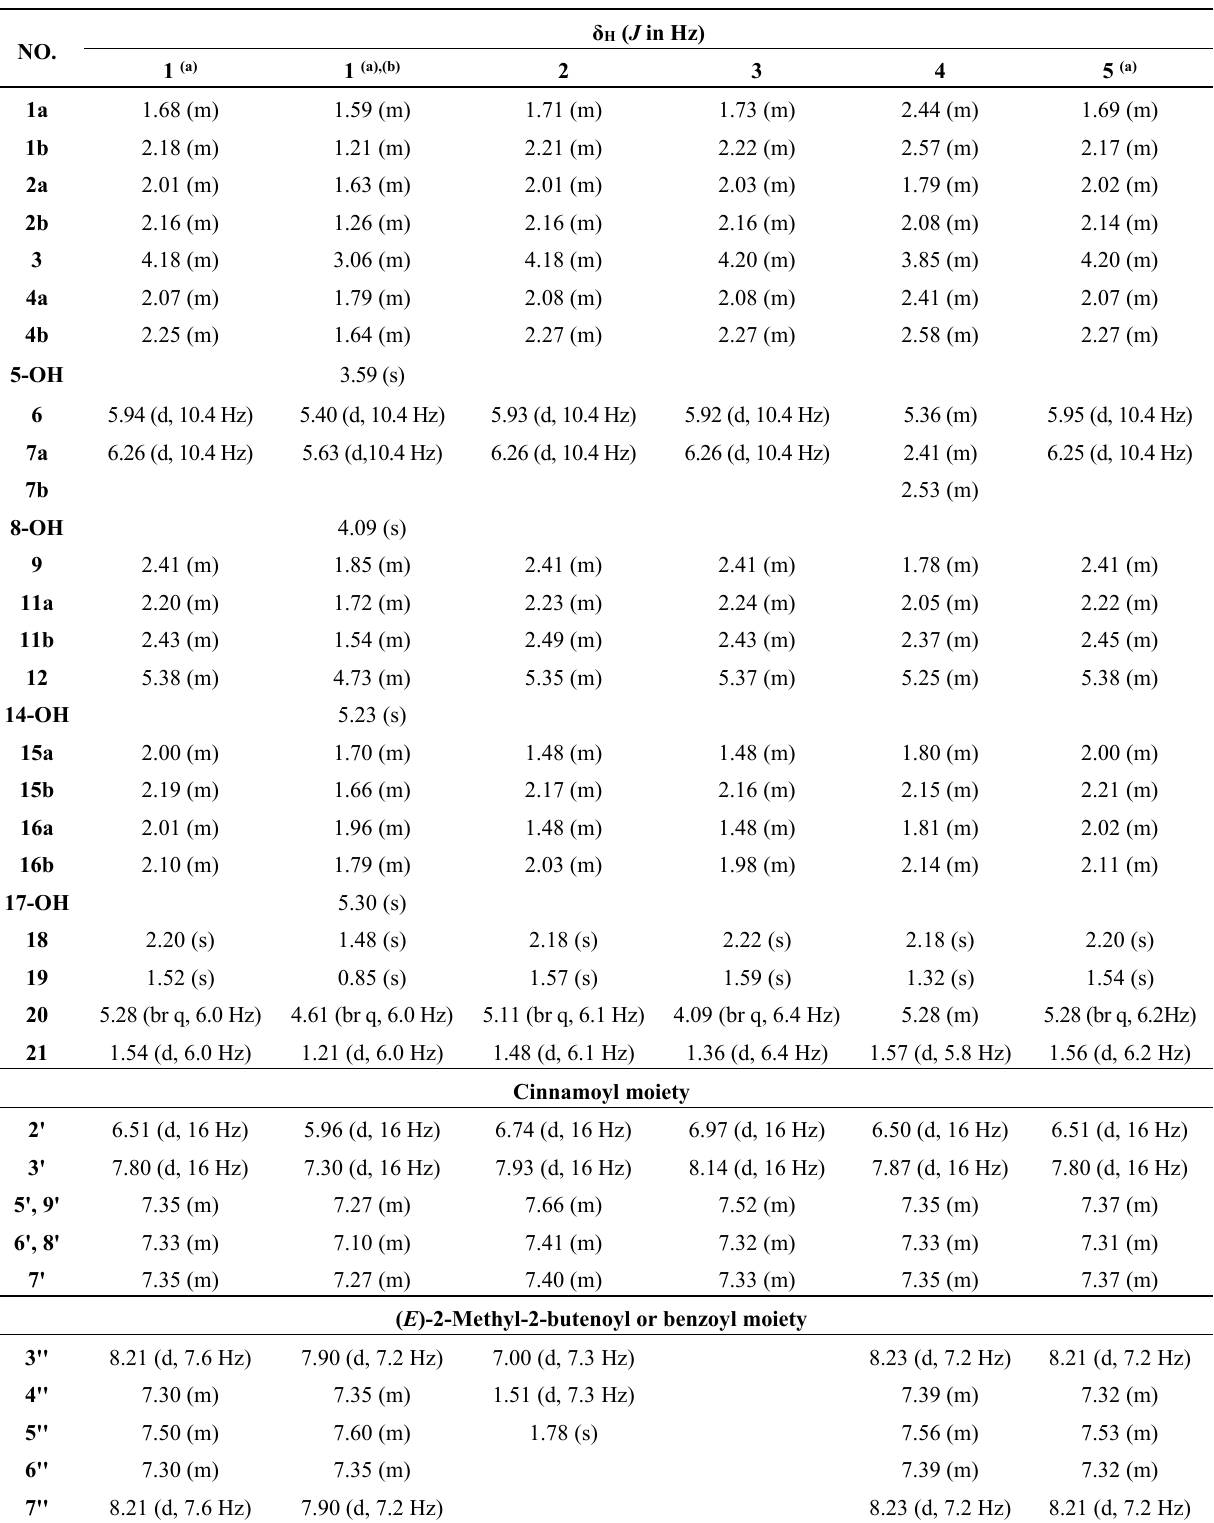
Table 1. 1 H-NMR (400 MHz) of the aglycones of compounds 1 – 5 (in pyridine -d 5 , J in Hz).